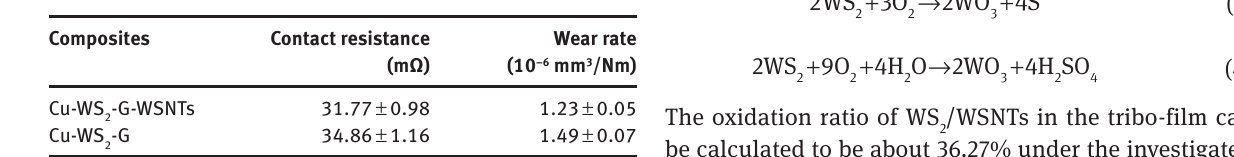
Table 2: Contact resistances and wear rates of Cu-WS